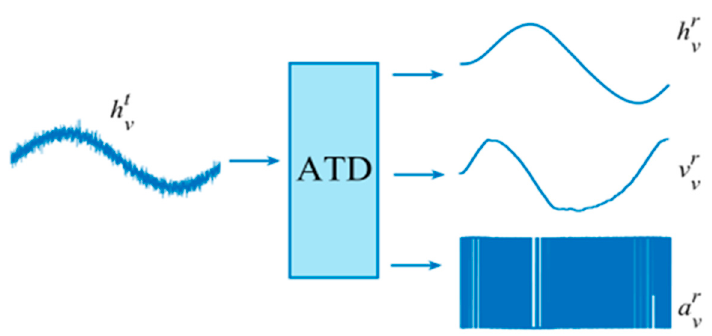
Figure 9. Diagram of generated reference trajectory according to the state information of moving targets.